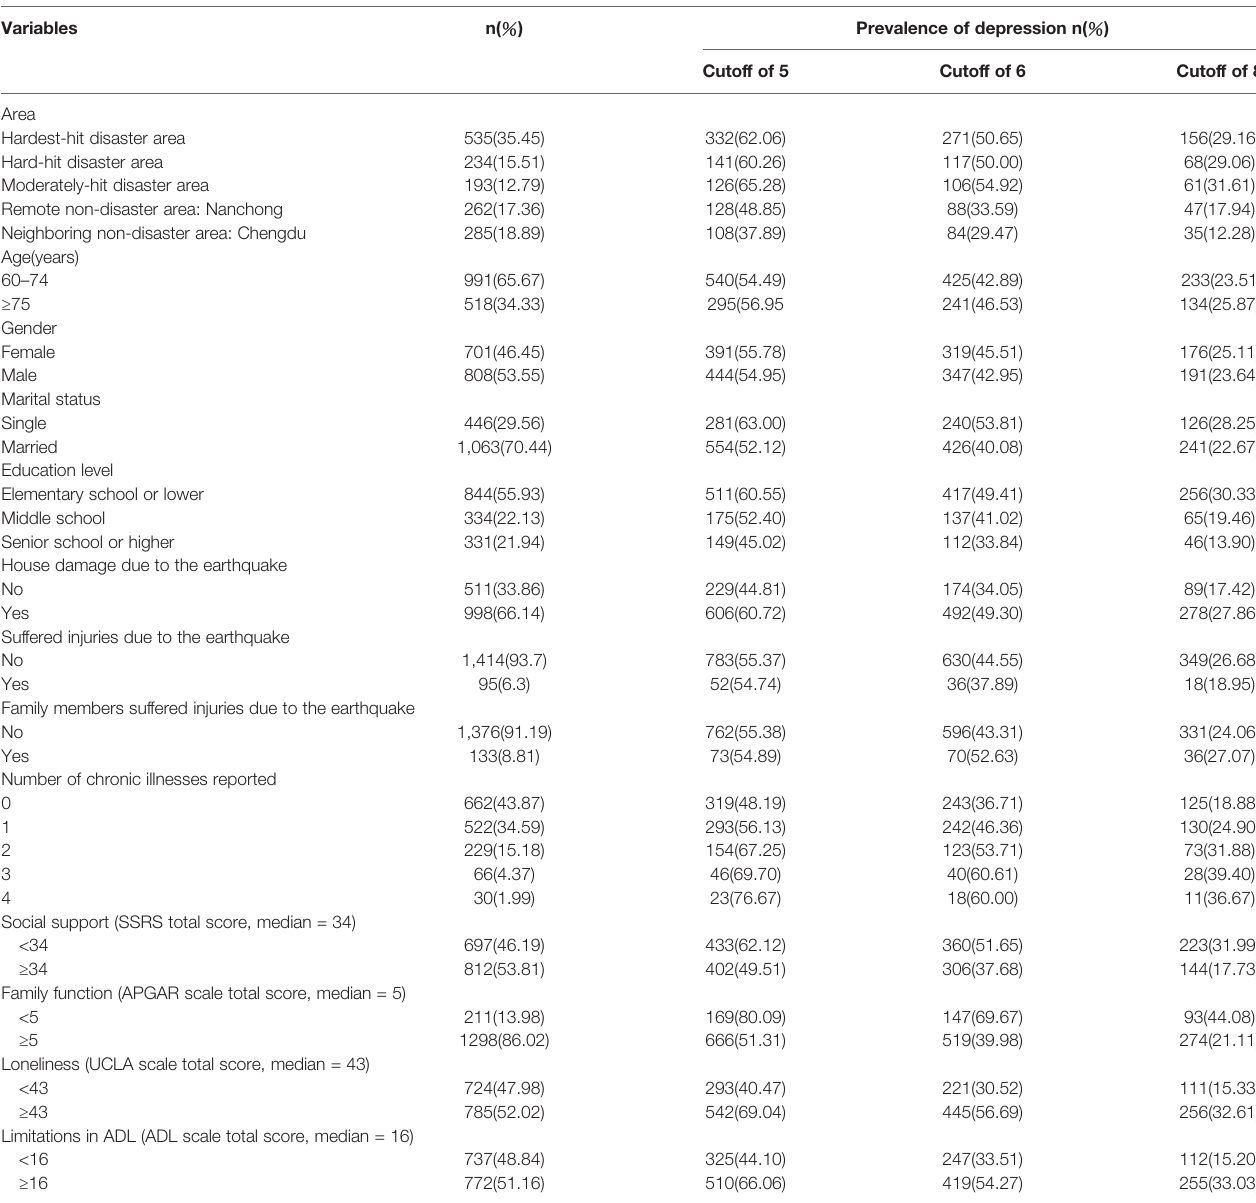
TABLE 2 | Descriptive characteristics of the 1,509